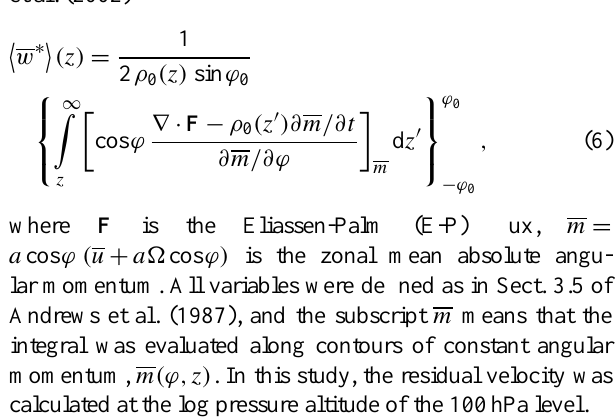
Fig. 6. Lagged correlations between the area covered with DTs, i.e., the time series FA, and the area weighted mean of specific humidity in the latitudinal band 50 ◦ S–50 ◦ N derived from the HALOE and Aura MLS instruments. The right panel shows the correlations between the two time series after the QBO, ENSO and solar cycle signals have been removed by a multilinear regression. Absolute correlation values greater than 0.3 are statistically significant above the 95% level (see text). Positive lags mean that DTs are leading.